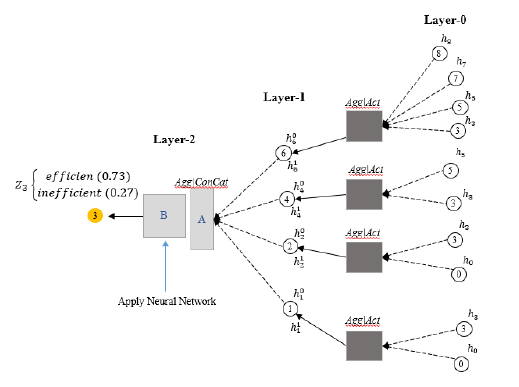
Figure 3 . Computation graph of Node 3 (neighbor depth -